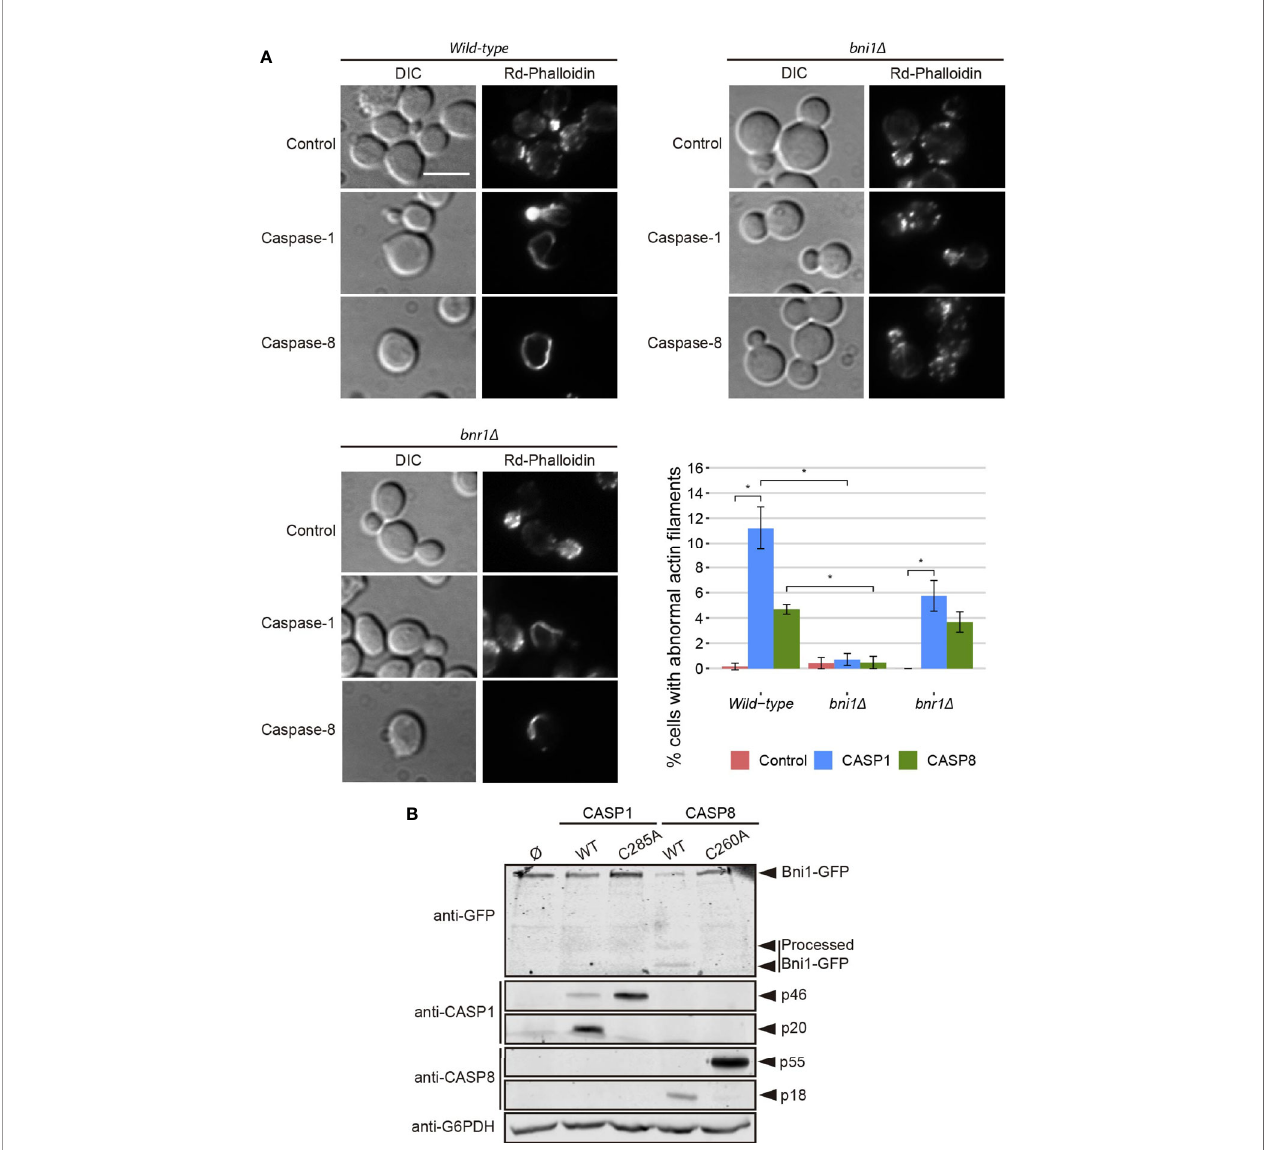
FIGURE 5 | Caspase-1 and caspase-8 overexpression alters actin cytoskeleton via Bni1 proteolysis. (A) Acting staining with rhodamine-phalloidin, bright fi eld (DIC) microscopy, and quanti fi cation (n > 200) of the percentage of cells showing abnormal actin structures of BY4741 wild type, and isogenic bni1 D and bnr1 D strains bearing the same plasmids as in Figure 1B . Scale bar indicates 5 µm. Error bars represent SD. Asterisks (*) indicate a p-value < 0.05 by the Dunn ’ s test. (B) Immunoblots showing the degradation of Bni1-GFP and the expression of caspase-1, caspase-8,and their correspondent protease-death mutants in yeast lysates of BY4741 Bni1-GFP-HIS2MX6 strain bearing pAG416-Caspase-1, pAG416-Caspase-1 C285A, pAG416-Caspase-8, and pAG416-Caspase-8. pAG416 empty vector (Ø) was used as a negative control. Membranes were hybridized with anti-GFP, anti – caspase-1, and anti – caspase-8 antibodies. Anti-G6PDH antibody was used as a loading control. Caspase-1 and caspase-8 expression was induced in SG medium for 5 h in all cases. A representative blot from three different experiments with distinct transformants is